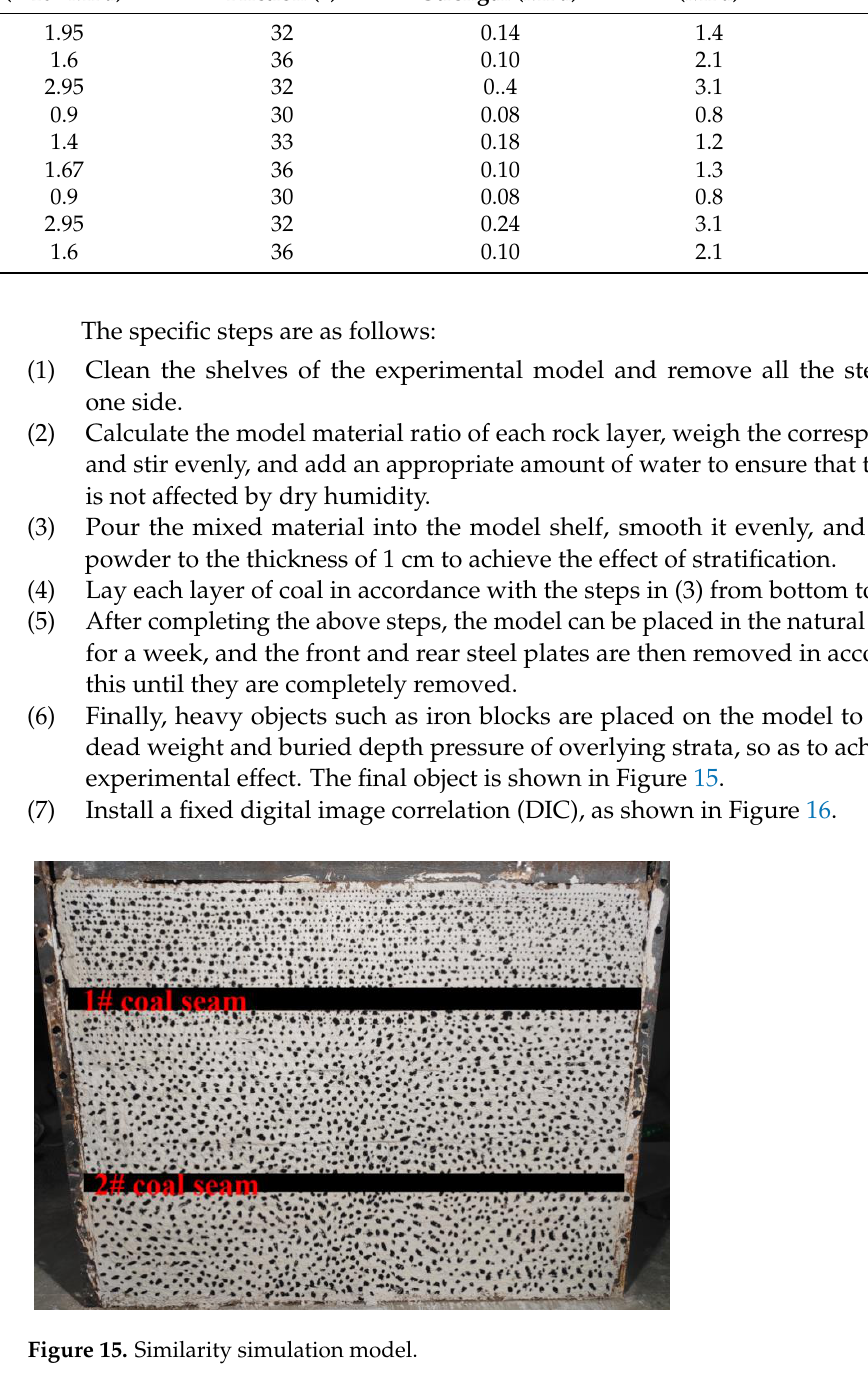
Figure 16. Digital image correlation. 5.2. Analysis of Similarity Simulation Results Figures 17 and 18 are the overlying rock strain diagrams and displacement diagrams combined according to the digital speckle system and the protective layer advancing at different distances. From Figures 17 and 18, we can obtain the following: (1) The 1# coal seam after excavation, the upper and lower strata fracture density with the advancement facing forward and becoming bigger, and the influence of the over- burden is slightly greater than the impact on the underlying strata. (2) Under the influence of coal mining, the upper and lower strata of the protective layer move in the direction of the goaf. The closer it is to the goaf, the larger its displace- ment is, with the maximum displacement appearing in the middle of the goaf, indi- cating that the region produces the most fractures and is influenced by mining. (3) It can be seen from the displacement diagram that the maximum downward caving distance of the roof of the protective layer is 3 cm, which is 3 m according to the similarity ratio, and the maximum displacement point is approximately 6 – 7 cm away from the bottom plate, indicating that the height of the caving zone is approximately 6 – 7 m after the mining of the protective layer, which is roughly the same as the the- oretical analysis. (4) As can be seen from the strain diagram, the maximum strain is 11.4, and the